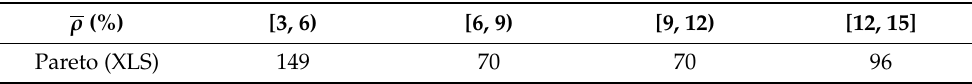
Table 6. The distribution for Pareto solutions of ρ for